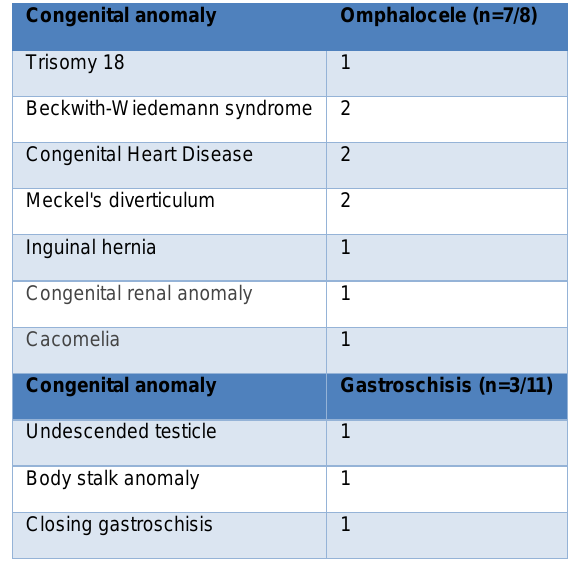
Table 2: Associated